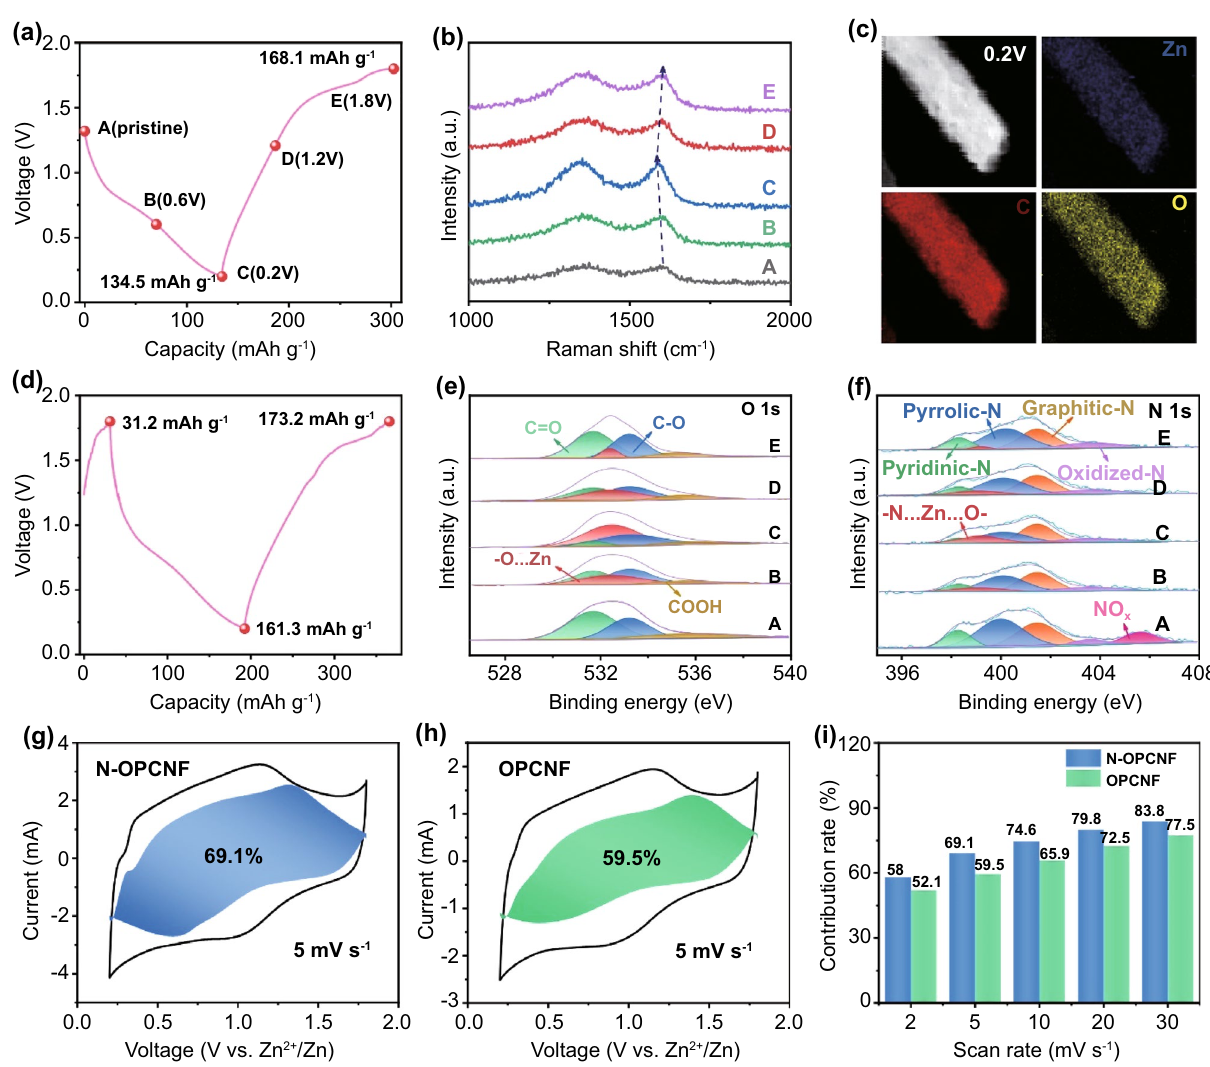
Fig. 3 a The first GCD profile in the mode of discharge first and charge at 0.1 A g −1 . b Ex-situ Raman spectra, c EDS mappings at full dis- charged state, d GCD profiles in the mode of charge first and discharge at 0.1 A g −1 . e Ex-situ O 1 s spectra. f Ex-situ N 1 s spectra. g Capacitive contribution at 5 mV s −1 of N-OPCNF. h Capacitive contribution at 5 mV s −1 of OPCNF. i Capacitive contribution ratio comparison at different scan rates for N-OPCNF and